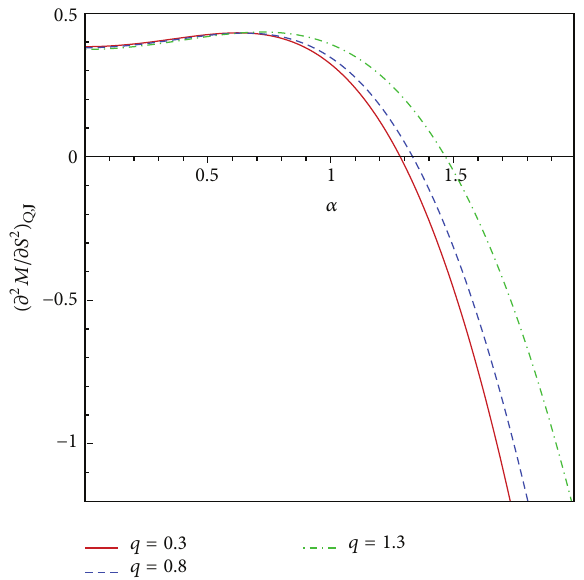
Figure 6: The behavior of (𝜕 2 𝑀/𝜕𝑆 2 ) 𝑄, J versus 𝛼 with 𝑙 = 𝑏 = 1 , = 1.5 , Ξ = 1.25 , 𝑛 = 5 , and 𝛽 = 2 . 𝑟 +